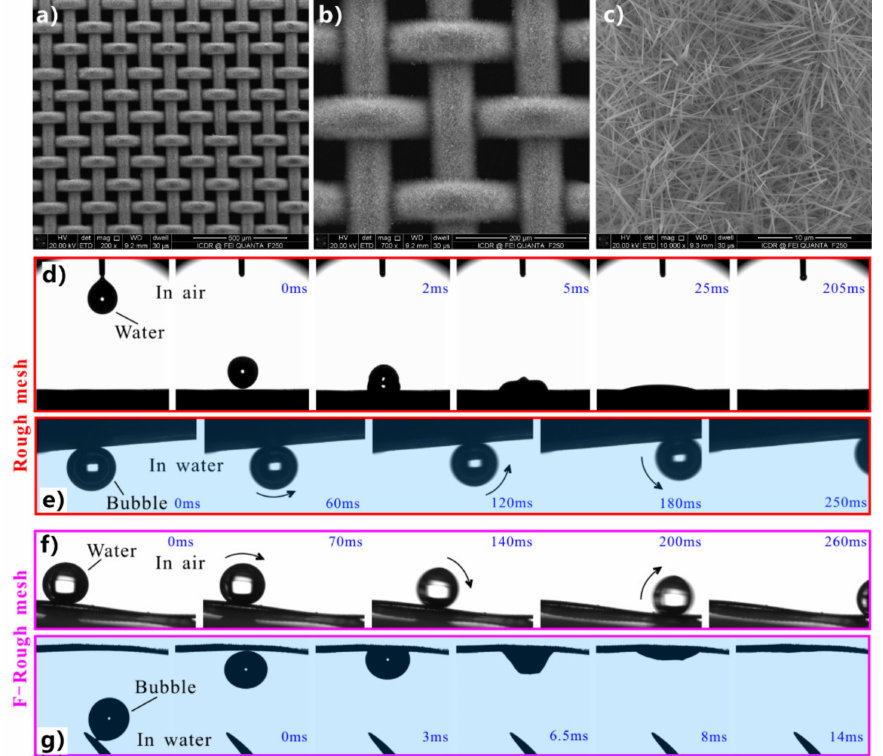
Figure 26. Underwater superaerophobicity and superaerophilicity of the nanoneedles-structured copper mesh. ( a – c ) Microstructure of the copper mesh with nanoneedles structure. ( d ) A water droplet falling onto the structure mesh in the air. ( e ) Underwater bubble rolling away on the structured mesh. ( f ) The rolling process of a water droplet on the fluoroalkylsilane-modified rough mesh in the air. ( g ) Releasing a bubble onto the modified rough mesh in water. Reprinted from ref.